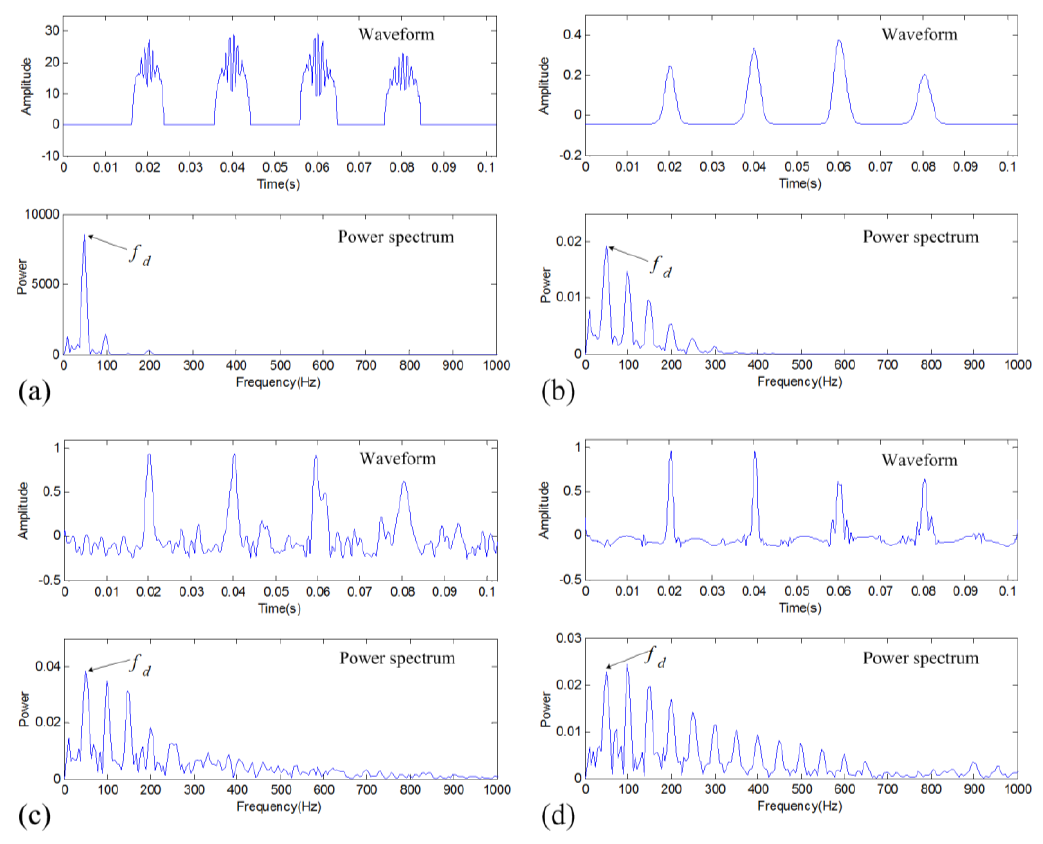
Figure 5. Fault diagnosis results of the simulation case for different methods: ( a ) FPTS spectrum of the TFM-based denoising result; ( b ) envelope spectrum of the TFM-based denoising result; ( c ) envelope spectrum of band-pass filtering result; and ( d ) envelope spectrum of DWT-based denoising